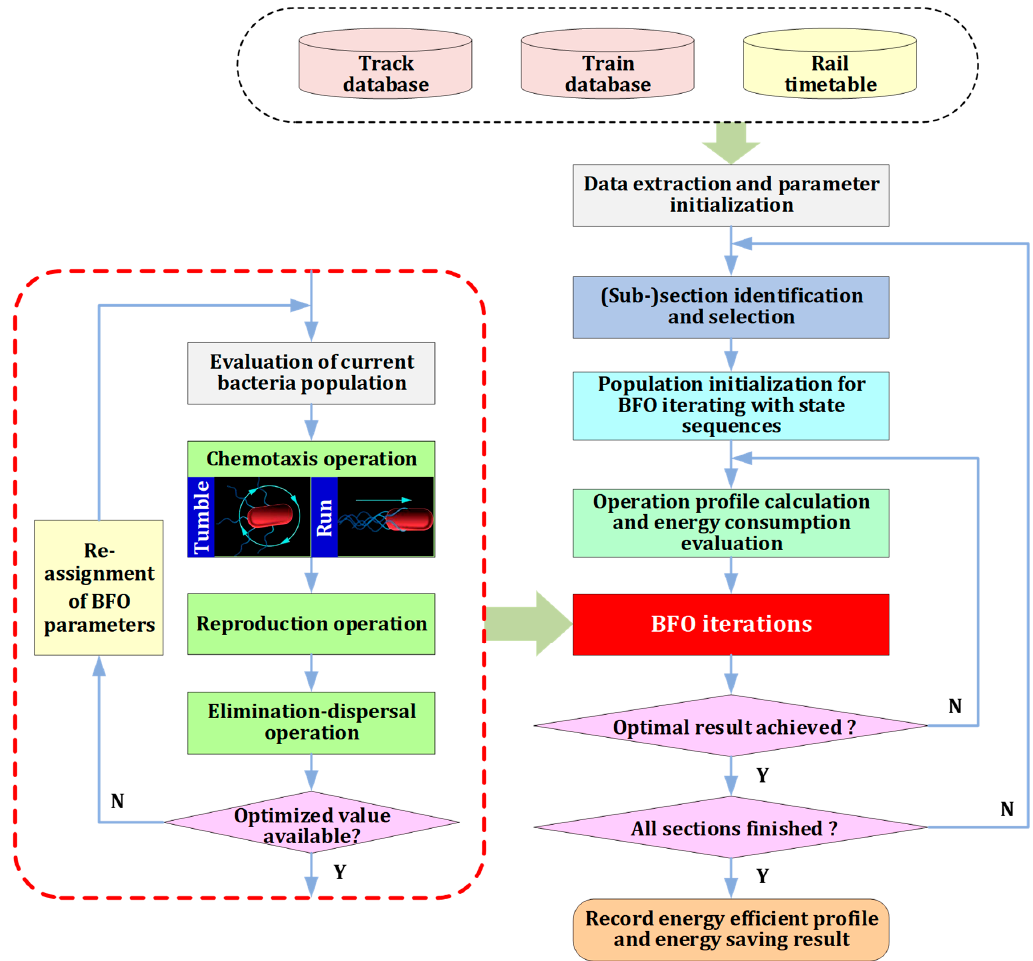
Figure 3. Flowchart of the energy-efficient traction solution calculation method.